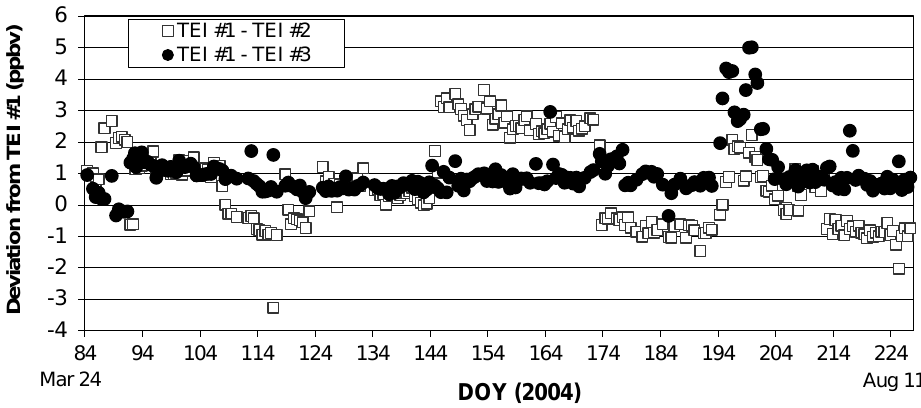
Fig. 4. Record of results in the TEI instrument deviations from the twice-daily inter-comparison measurements.